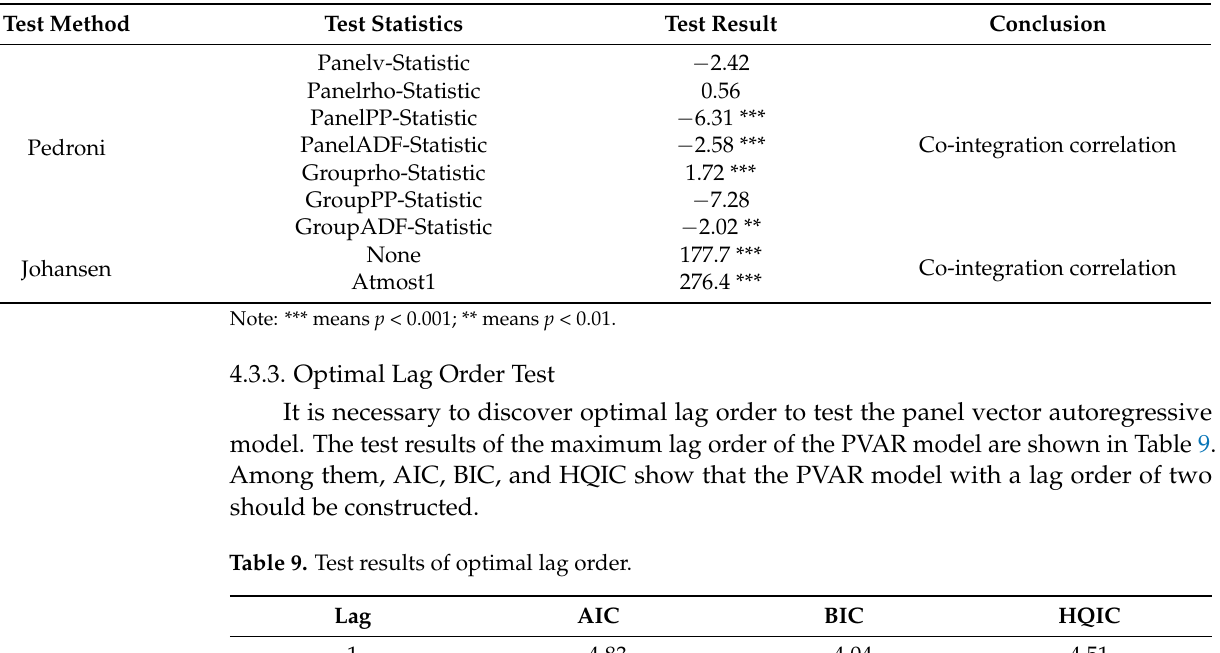
Table 8. Co-integration test results.